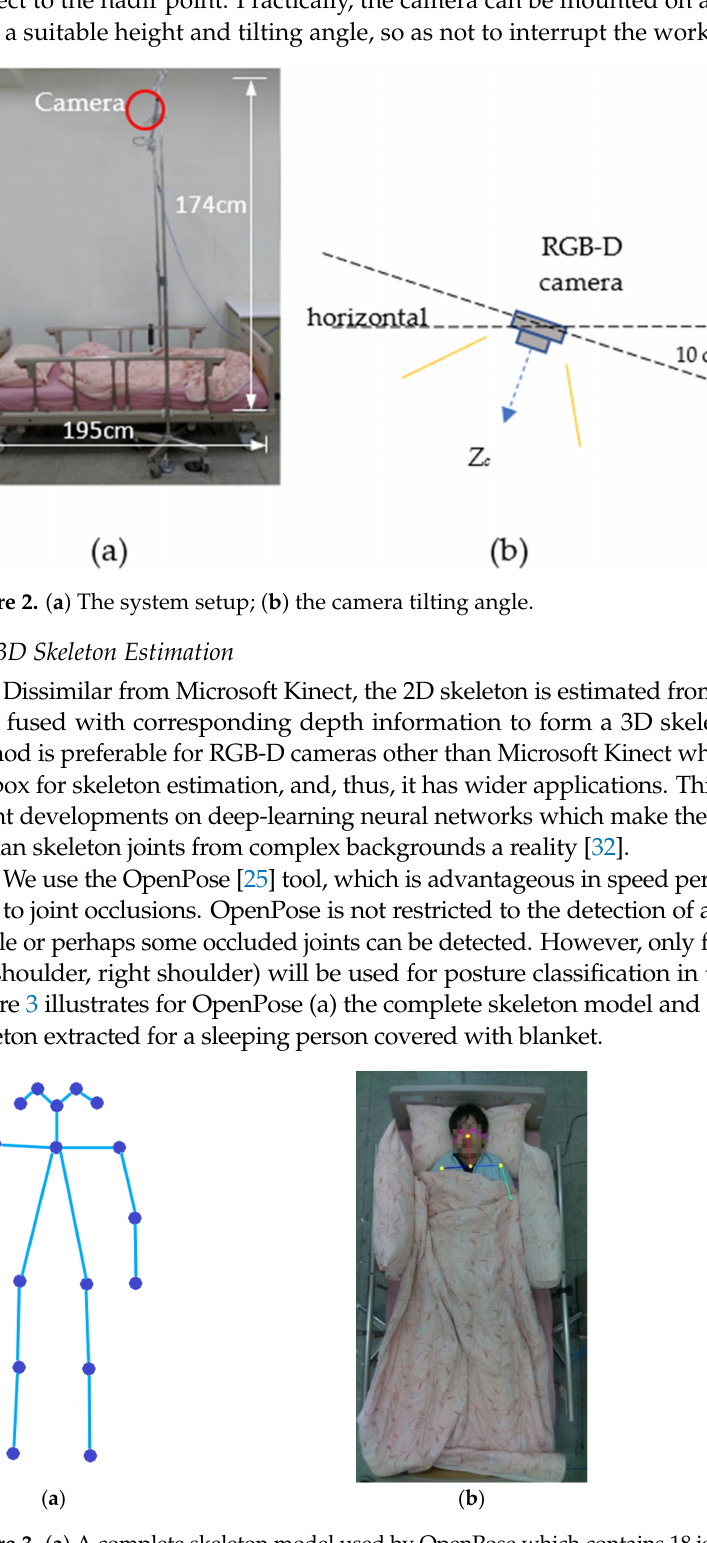
Figure 3. ( a ) A complete skeleton model used by OpenPose which contains 18 joints. ( b ) An example of 2D skeleton extracted for sleeping person (with blanket) by using